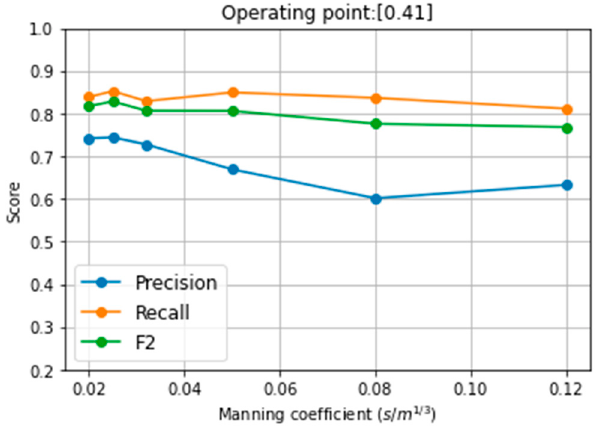
Figure 10. Accuracy measures as a function of the coefficient of Manning for operating point = 0.41.